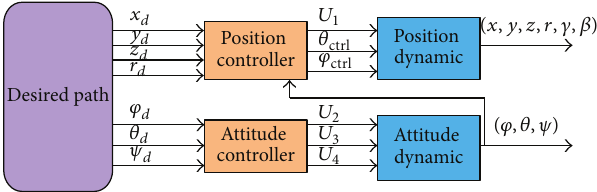
Figure 6: Block diagram of the considered control system.